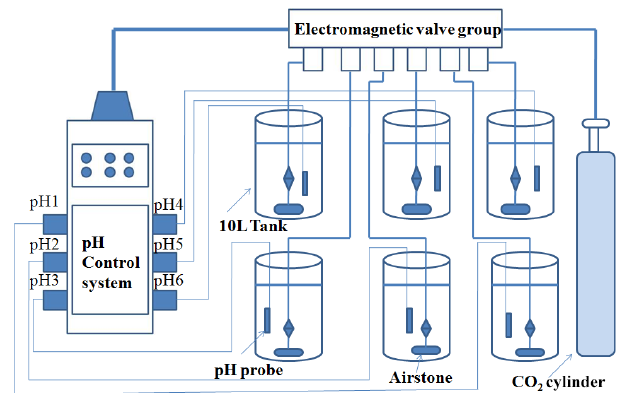
Figure 1. Schematic illustration of the pH control system applied in exposure experiment (For details refer to the